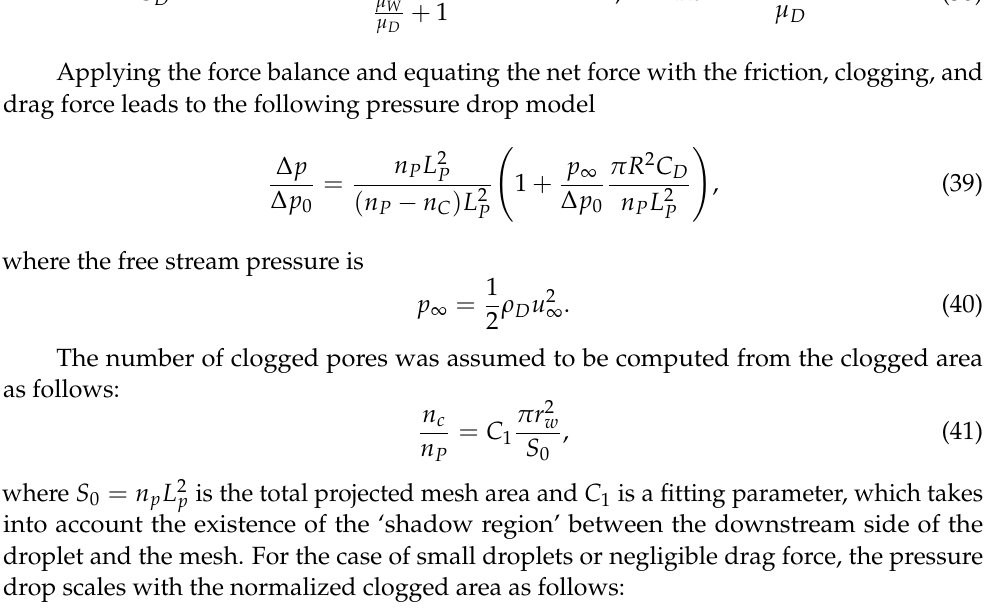
( b ) ( c ) Figure 19. Breakthrough mechanism of a water droplet through a wire mesh screen. ( a ) Sub-drop- lets start to form through clogged pores; ( b ) Coalescence of sub-droplets; ( c ) Breakthrough the wire mesh screen and the droplet is transported downstream. This mechanism is similar to what was discussed in the bubble point test. Hence, the same model was adopted to describe the threshold pressure at which breakthrough occurs. From the approximated Young–Laplace equation (Equation (15)) for a single pore, the threshold pressure reads Δ𝑝 ∗ = 0.95 𝑝 𝛾,𝑚𝑎𝑥 = 3.8 𝛾 sin(𝜃 𝑌𝐿 − 90 ∘ ) 𝐿 𝑃2 , (44) where the maximum capillary pressure in a single pore is 𝑝 𝛾,𝑚𝑎𝑥 = 4 𝛾 sin(𝜃 𝑌𝐿 − 90 ∘ ) 𝐿 𝑃2 , (45) Figure 20 shows the normalized averaged wetting versus the normalized pressure drop. All the data points of the captured droplets were found to be bounded with a